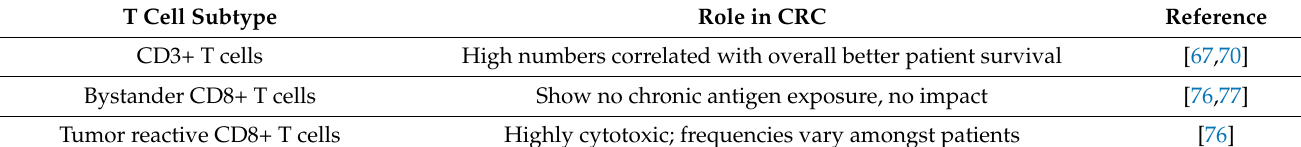
Table 1. Impact of type, numbers, and activity of T cells on colorectal cancer development. T Cell